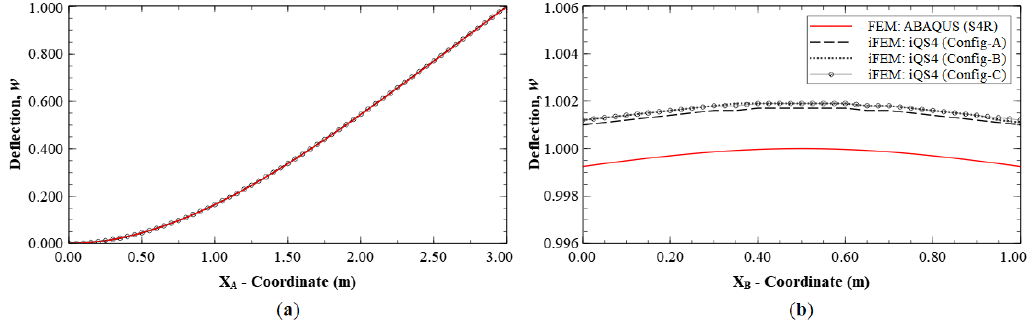
Figure 6. Line plots of deflection ( w ) for Mode 1 along: ( a ) section A-A’; and ( b ) section B-B’.